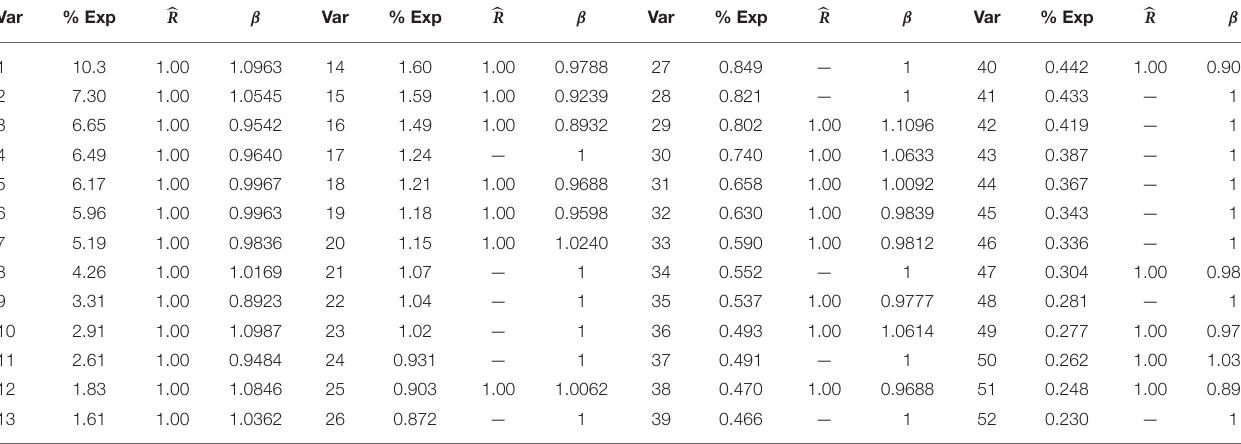
R , and medians for posterior distributions of coefficients for synthetic variables ( β ) returned by FAMD. TABLE 3 | Percentage of variance explained, b